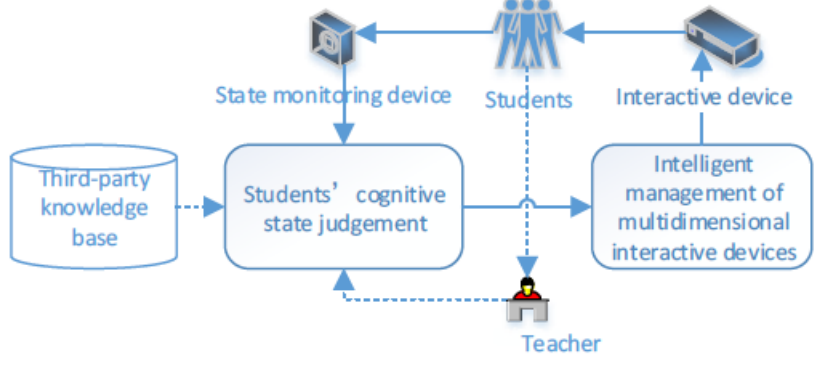
Fig. 1. Management framework of